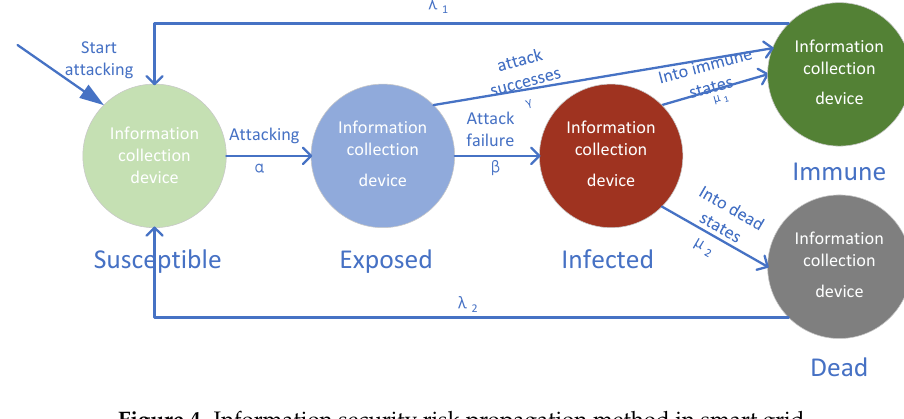
Figure 4. Information security risk propagation method in smart grid. Table 1. Risk assessment model